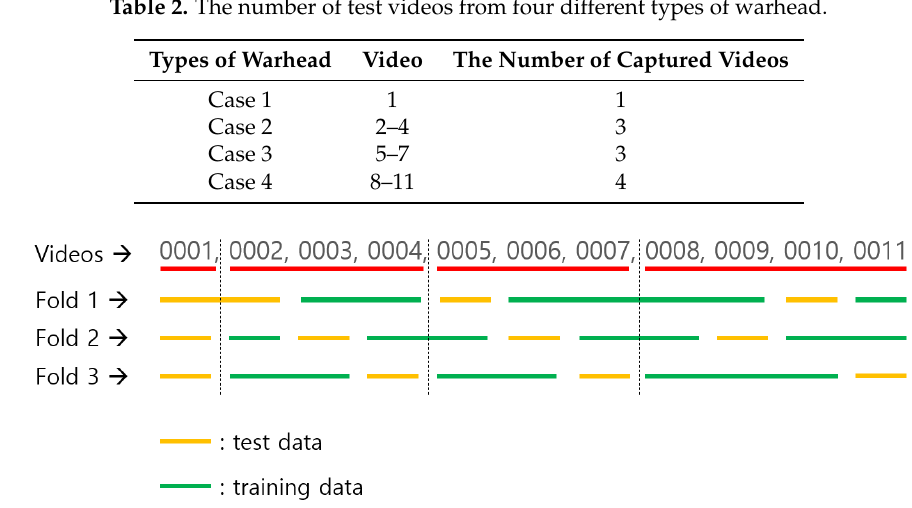
Figure 12. Data organization for the three-fold